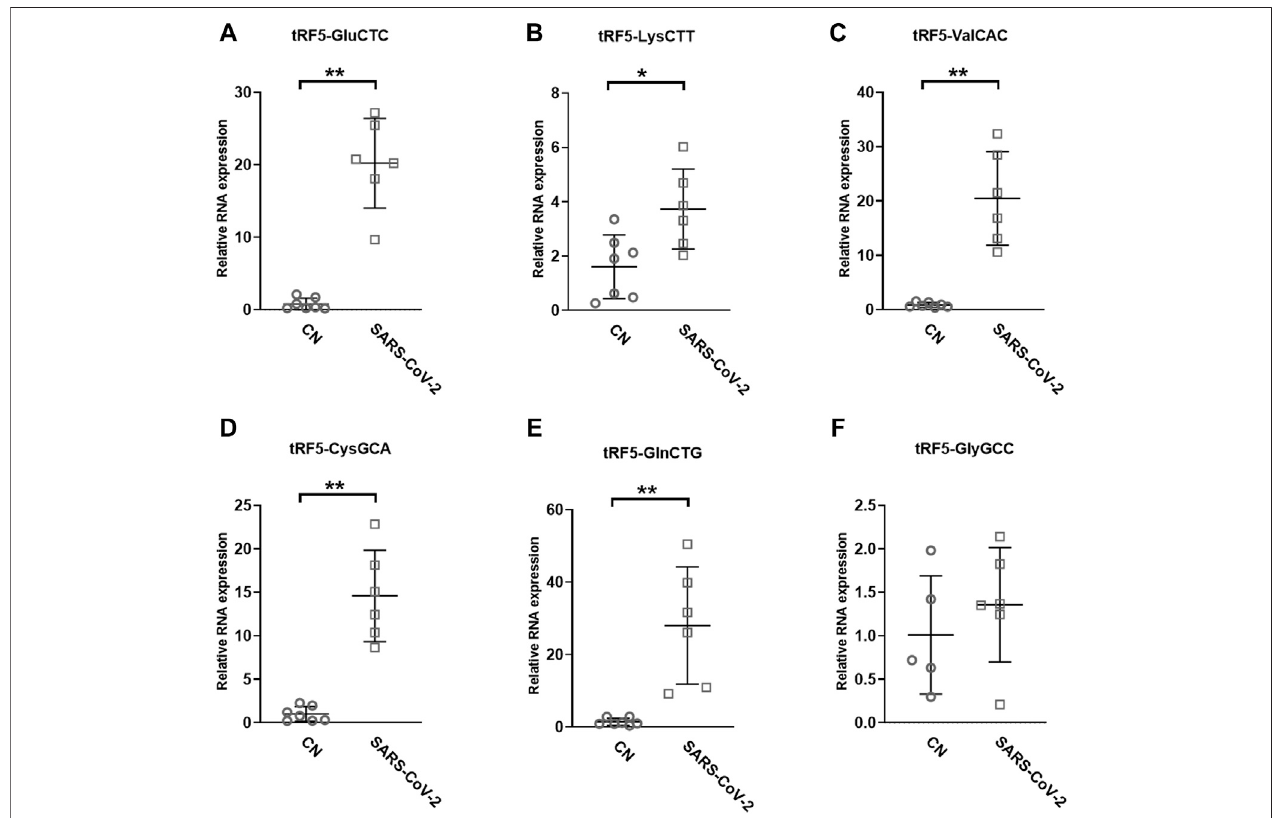
FIGURE 3 | Changes in the expression of tRF5s in NPS samples by SRAS-CoV-2. qRT-PCR was performed to detect tRF5-GluCTC (A) , tRF5-LysCTT (B) , tRF5- ValCAC (C) , tRF5-CysGCA (D) , tRF5-GlnCTG (E) , and tRF5-GlyGCC (F) in the NPS from SARS-COV-2 and control (CN) patients. U6 was used as an internal control. Unpairedtwo-tailedMann-Whitney U testswereperformedforstatisticalcomparisons.Single anddoubleasterisksrepresent p valuesof < 0.05 and < 0.01, respectively. Data are shown as means ± SE.